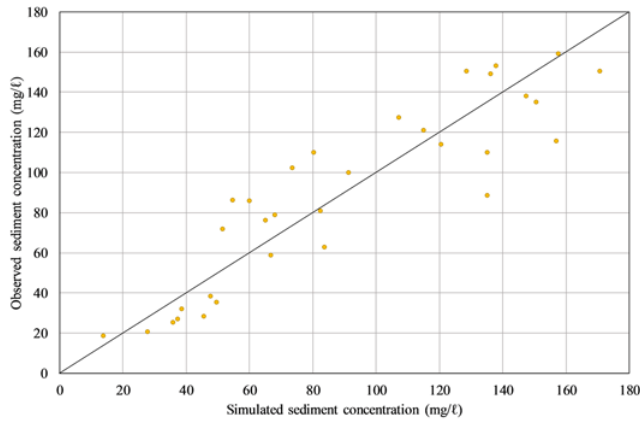
Figure 5. Observed and simulated sediment concentration for period (1961–1968) at the Derbendekhan watershed.